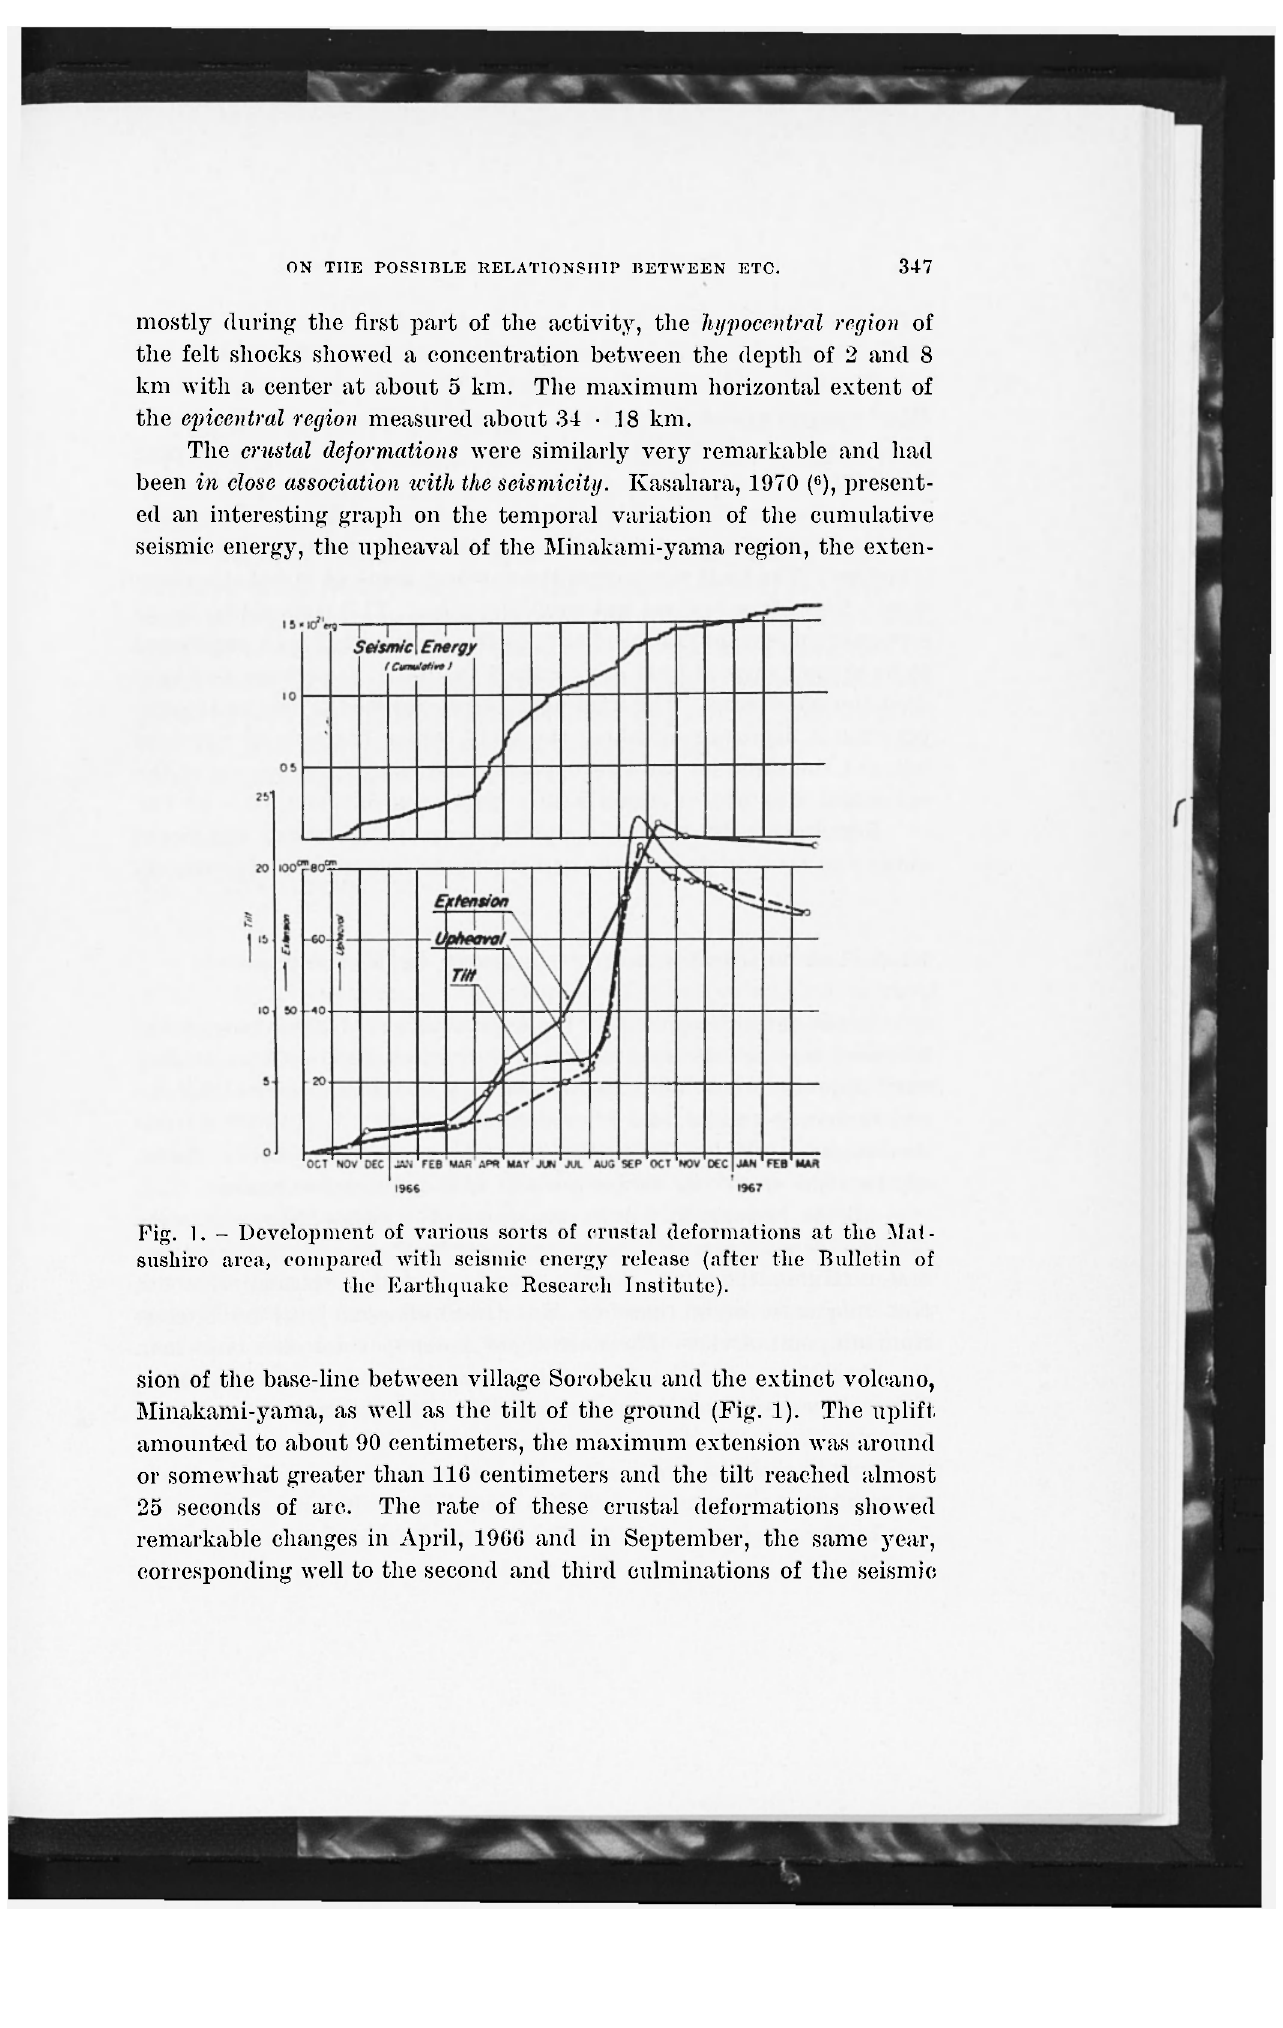
Fig. 1. - Development of various sorts of crustal deformations at the Mat- susliiro area, compared with seismic energy release (after the Bulletin of the Earthquake Research